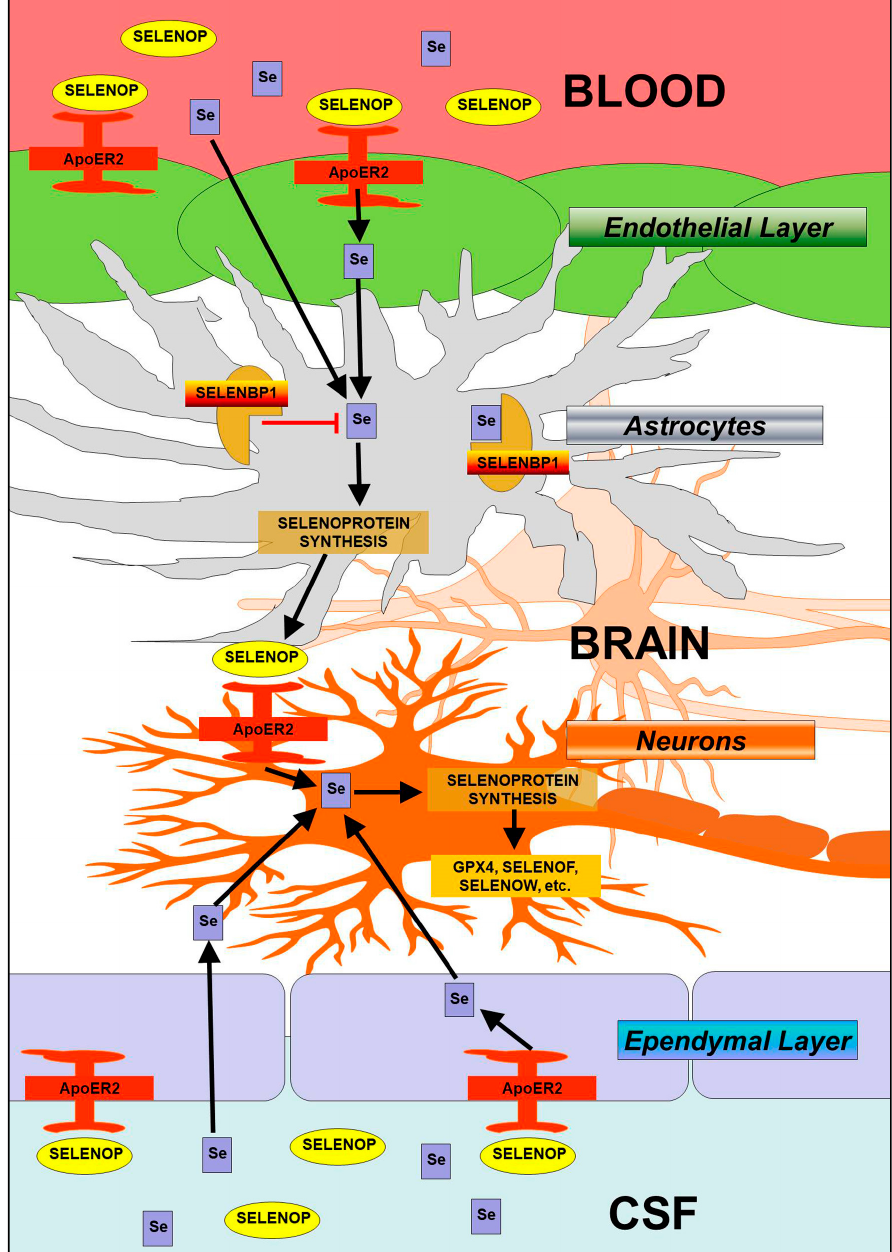
Figure 8. Hypothetical model of Se homeostasis in brain. Circulating SELENOP present in blood and cerebrospinal fluid (CSF) is taken up by LRP8-positive cells in the epithelial (blood–brain barrier) and ependymal (brain–CSF barrier) layers, resynthesized in neighboring astrocytes, and released to supply LRP8-positive neurons with Se. Within astrocytes, SELENBP1 may sequester Se away from selenoprotein synthesis and thereby negatively regulate SELENOP synthesis. Evidence also indicates the existence of parallel, non-SELENOP pathway by which a small molecule form of Se enters the brain.